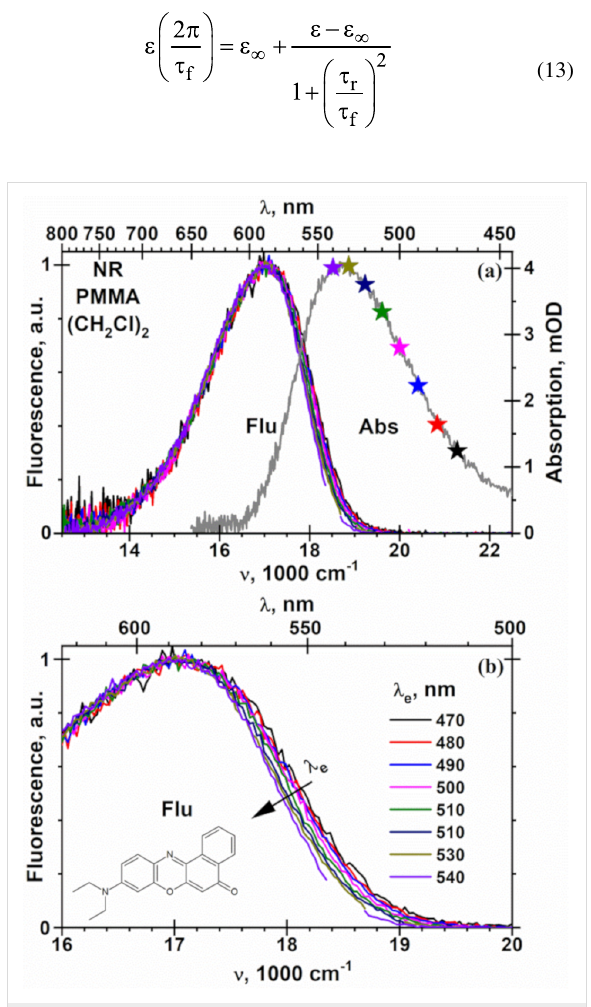
Figure 4: Absorption (a) and fluorescence (a, b) spectra of NR in PMMA (350 kg/mol) film 500 nm thin at different excitation wavelength ( λ e ). The film was prepared by spin-coating of PMMA solution in 1,2- dichloroethane ((CH 2 Cl) 2 ) on the 20 × 20 × 0.15 mm 3 glass doped with NR. The concentration of NR in the PMMA film of 2.1 mM was calculated from the optical density (panel (a)) and thickness of PMMA film with the molar extinction coefficient NR in 1,4-dioxane of 38000 M − 1 ·cm − 1 [68]. The λ e values are indicated with stars on the absorption spectrum in panel (a). The regions λ e ± 5 nm in the fluores- cence spectra (a, b) are not shown due to overlap with strong scat- tering excitation